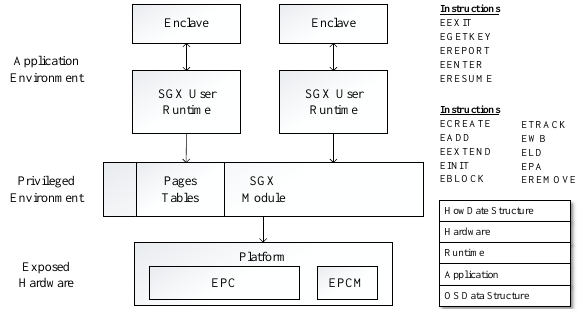
Figure 1. Architecture description of Software Guard Extensions